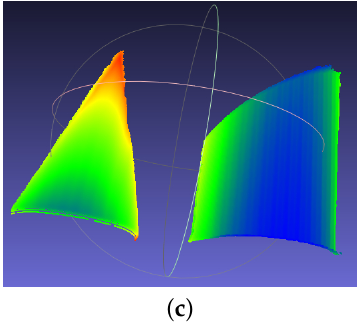
Figure 14. 3D measurement by the fringe projection vision system. ( a ) Absolute phase map; ( b ) measured 3D surface for discontinuous objects in Matlab; and ( c ) measured 3D surface for discontinuous objects, shown in Meshlab